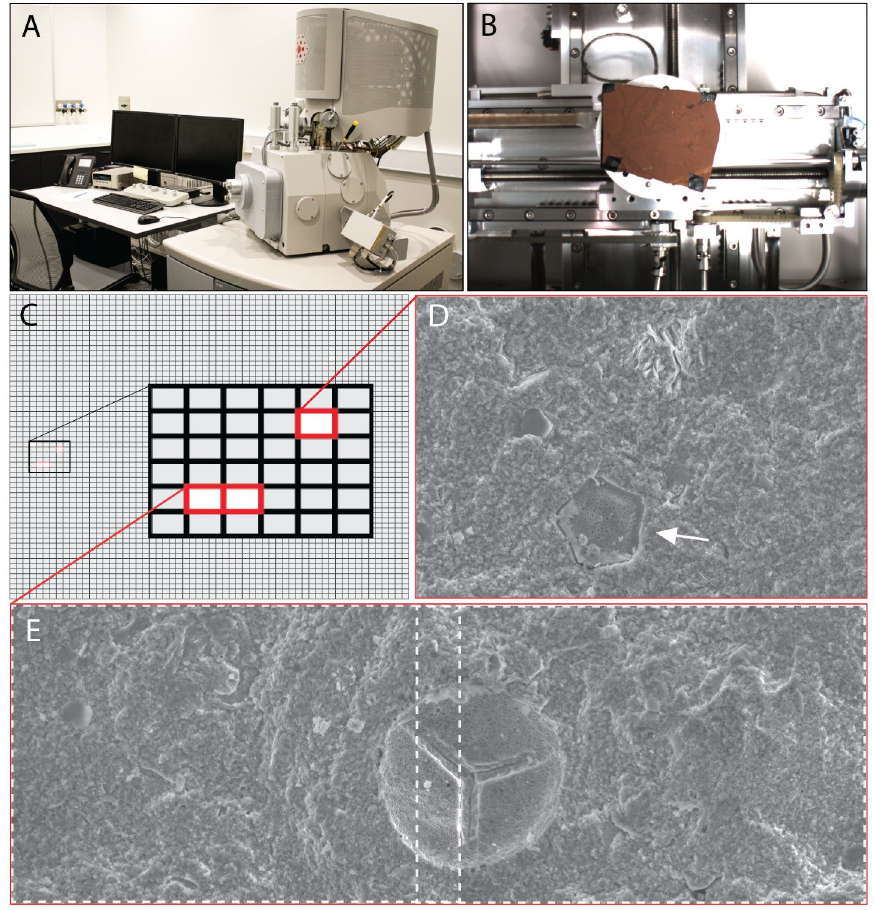
Fig 2. Automated image acquisition. ( a ) FEI QEM SCAN 650F scanning electron microscope (SEM). ( b ) A representative rock sample (AM F.147103) from McGraths Flat (approx. 50 × 60 mm) used for automated image acquisition; the photograph was taken using the microscope chamber’s digital camera. The flat surface of the rocks and their iron-rich composition makes it simple to maintain focus, as well as provide the conductivity needed for SEM operation without applying a conductive coating to the sample. ( c ) Schematic depiction of a 60 × 60 (3600) image montage; the area covered by 3600 images is 0.265 cm 2 (note that neighbouring images have a 12.5% overlap). ( d , e ) SEM images that contain microfossils: d —image showing a single pollen ( Nothofagidites emarcidus/heterus) ; and, e — two neighbouring images (dashed lines) showing an unknown spore. The images were electronically stitched together using Kolor Autopano Pro 4. The SEM images have not been adjusted for contrast and appear in the same format as viewed by volunteers.